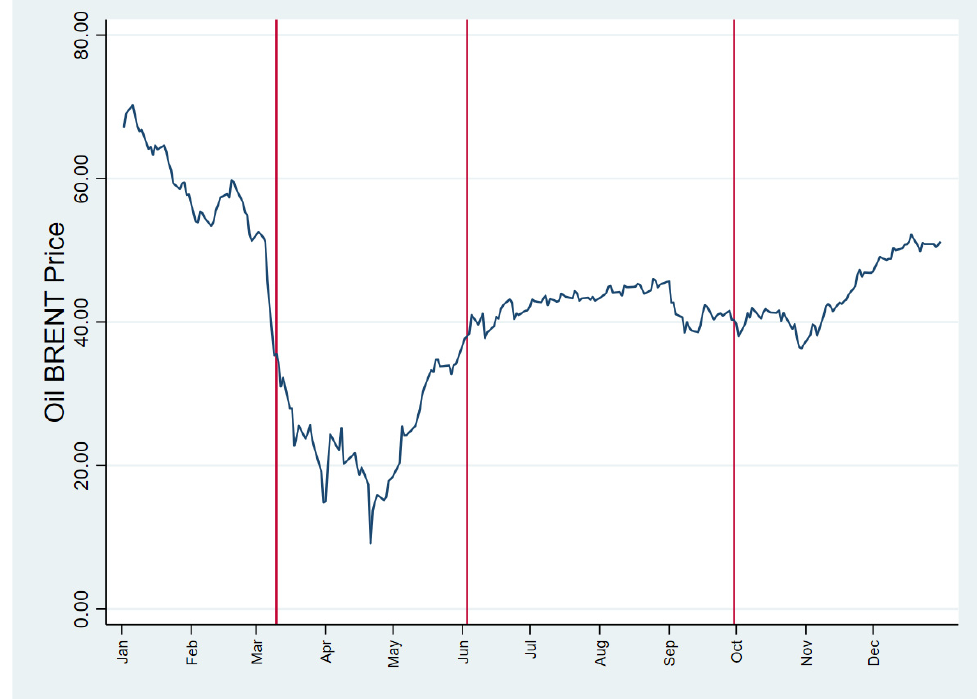
Figure 10. Daily BRENT Oil Price, 2020. Source: Federal Reserve Economic Data; https://fred.stlouisfed.org. Crude Oil Prices: Brent-Europe, Dollars per Barrel, Daily, Not Seasonally Adjusted (accessed on 1 June 2022).